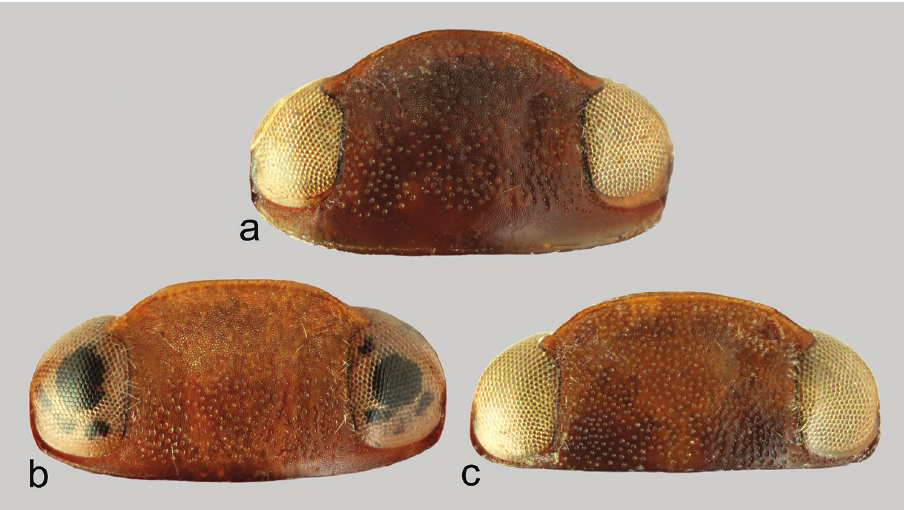
Figure 6. Hyphydrus head. a H. anatolicus b H. ovatus c H. sanctus . Not in scale.